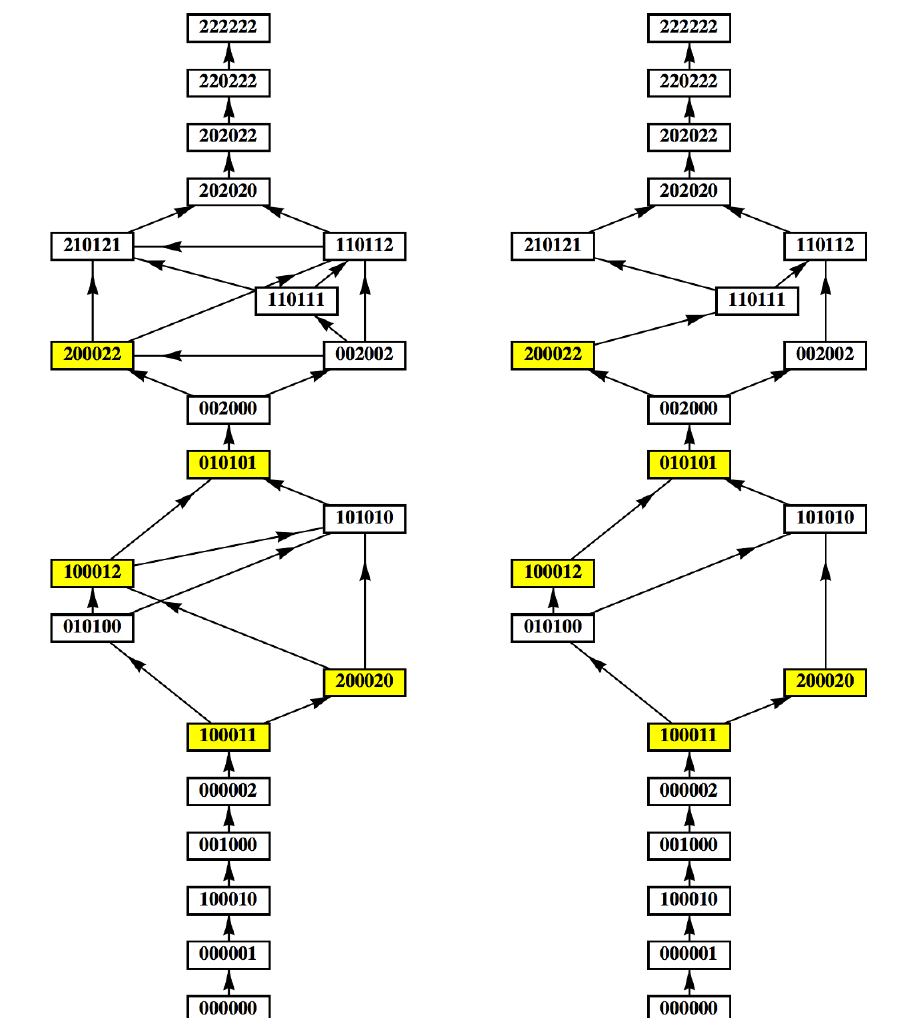
Figure 4 . E 6 nilpotent orbit Hasse diagram. The left hand diagram is indicative, being partly derived from unre(cid:12)ned Hilbert series, with arrows indicating inclusion relations and yellow nodes indicating non-normal nilpotent orbits. The right hand diagram is taken from the mathematical